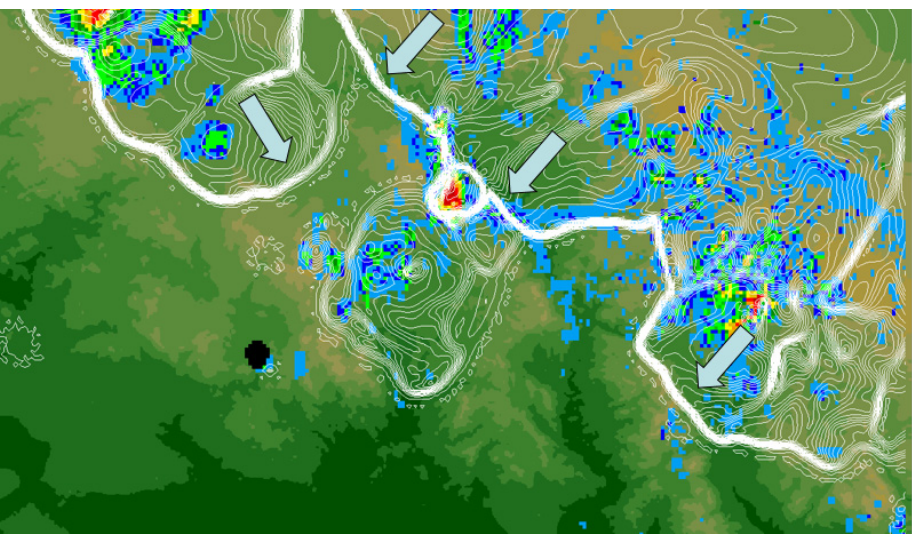
Figure 6. Same as for Figure 5 but valid for 1335 LST.